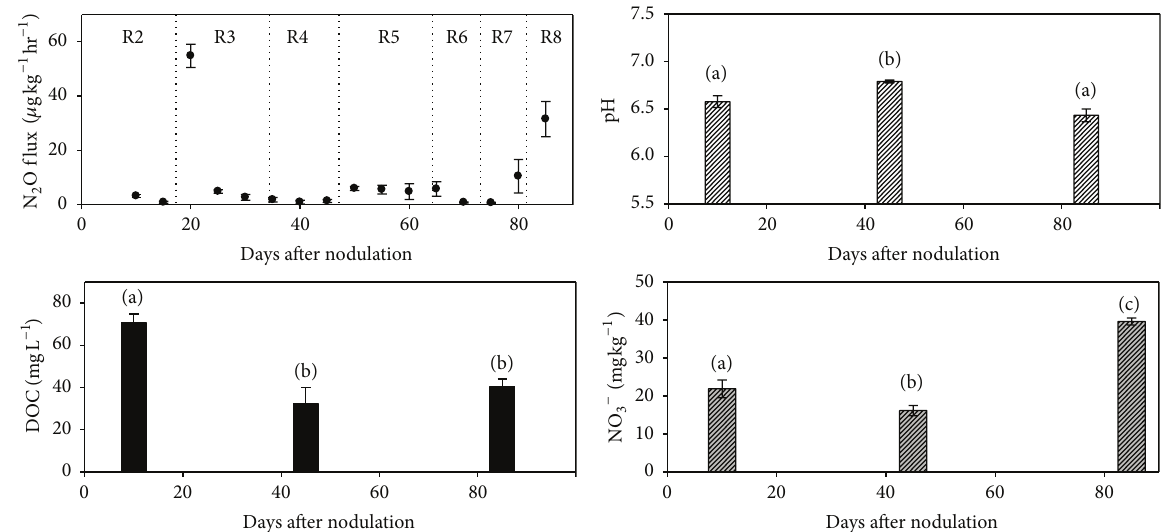
Figure 1: Temporal dynamics of N 2 O flux ( 𝜇 g kg −1 hr −1 ), soil pH, DOC (mgL −1 ), and NO 3− -N (mgkg −1 ) of IS treatment. Different lower case letters indicate a statistically significant difference at 𝛼 = 0.05. R2: full flowering; R3: beginning pod; R4: full pod; R5: beginning